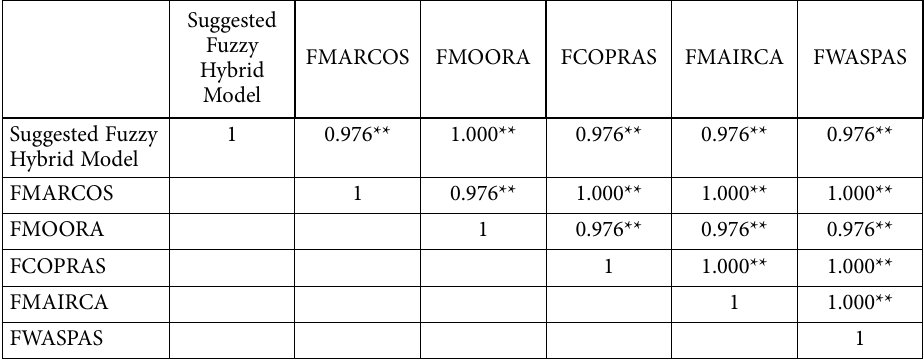
Suggested Fuzzy FMARCOS FMOORA FCOPRAS FMAIRCA FWASPAS Hybrid Model 1 0.976** 1.000** 0.976** 0.976**